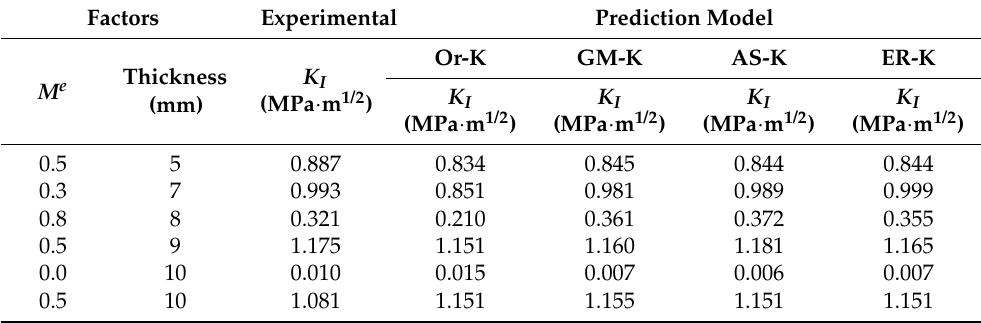
Table 3. Mode I fracture toughness from models’ testing